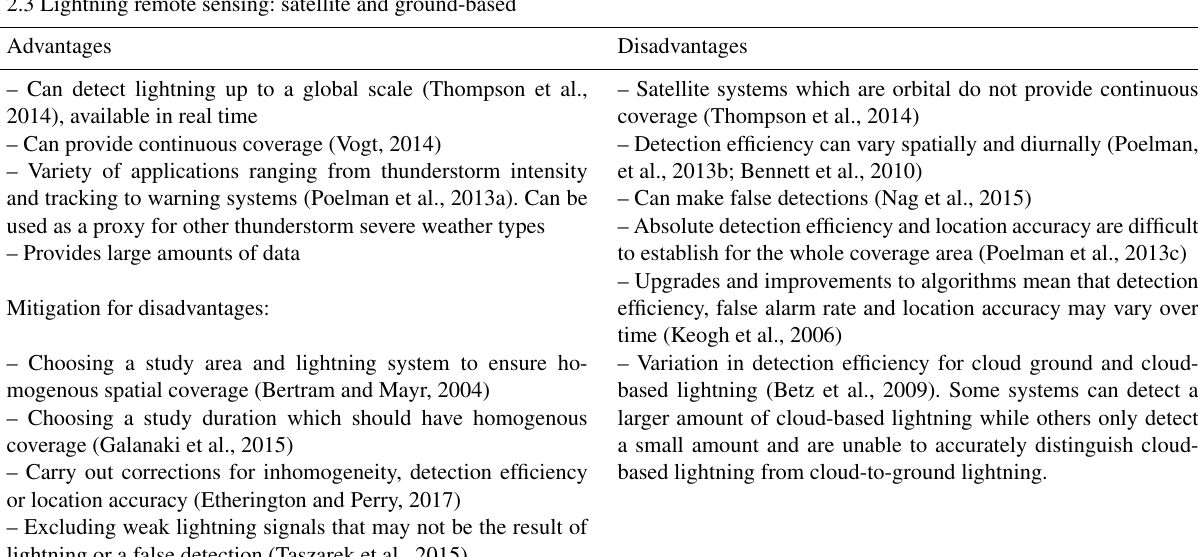
Table 3. Strengths and weaknesses of lightning remote sensing (satellite and ground-based) used to produce thunderstorm and lightning